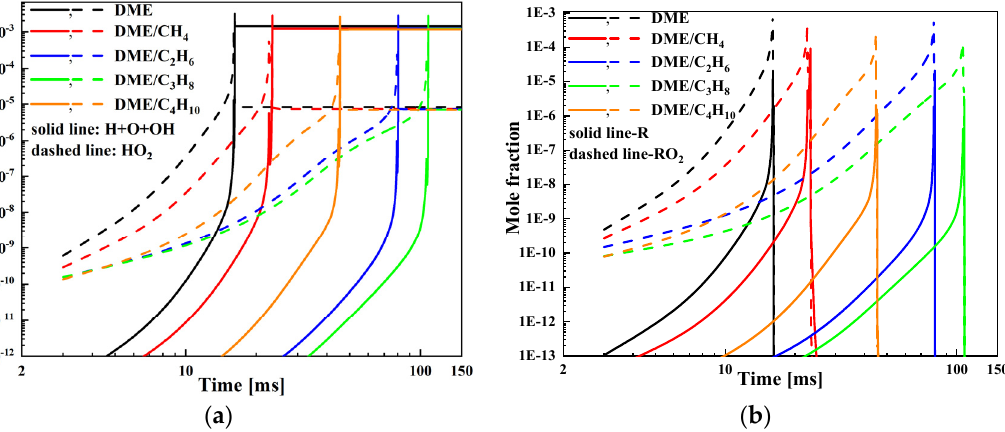
Figure 5. Mole fraction of various species for DME/C1-C4 alkane mixtures at T c = 650 K, P c = 20 bar, and φ = 0.5: ( a ) H, O, OH, HO 2 and ( b ) R, RO 2 .